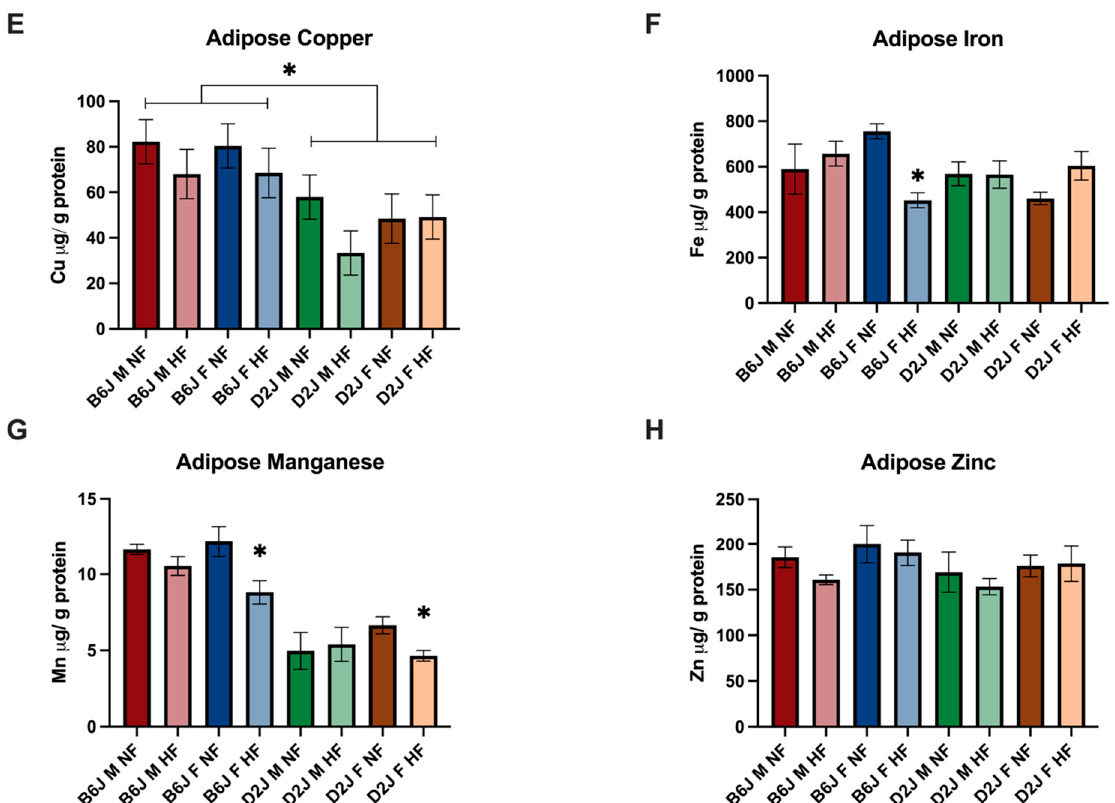
Figure 2. Liver and adipose trace element concentration by diet, sex, and strain. Atomic absorp- tion spectrometry was used to determine copper, iron, manganese, and zinc concentration in µ g of element/dL of tissue. ( A ) Liver copper concentrations were significantly decreased in D2J males (* p < 0.001). ( B ) There was a significant three-way interaction between sex, strain, and diet for liver iron concentrations, which were significantly reduced for B6J male and female mice (* p < 0.001). ( C ) Liver manganese concentrations were significantly increased in D2J females (* p < 0.001). ( D ) Liver zinc concentrations were significantly increased for B6J males and females (* p < 0.001 and p = 0.005). ( E ) There was a statistically significant main effect of strain on adipose copper con- centration (* p = 0.001). ( F ) Adipose iron concentrations were significantly reduced in B6J males (* p = 0.002). ( G ) Adipose manganese concentrations were significantly decreased in B6J and D2J females (* p = 0.016 and p = 0.039). ( H ) There were no strain, sex, or sex interactions effects for zinc in adipose tissue. The asterisk (*) indicates statistical significance between normal-fat (NF) and high-fat (HF) diet groups. Data are represented as mean ± SEM. B6J M NF = B6J male normal fat, B6J M HF = B6J male high fat, B6J F NF = B6J female normal fat, B6J F HF = B6J female high fat, D2J M NF = D2J male normal fat, D2J M HF = D2J male high fat, D2J F NF = D2J female normal fat, D2J F HF = D2J female high